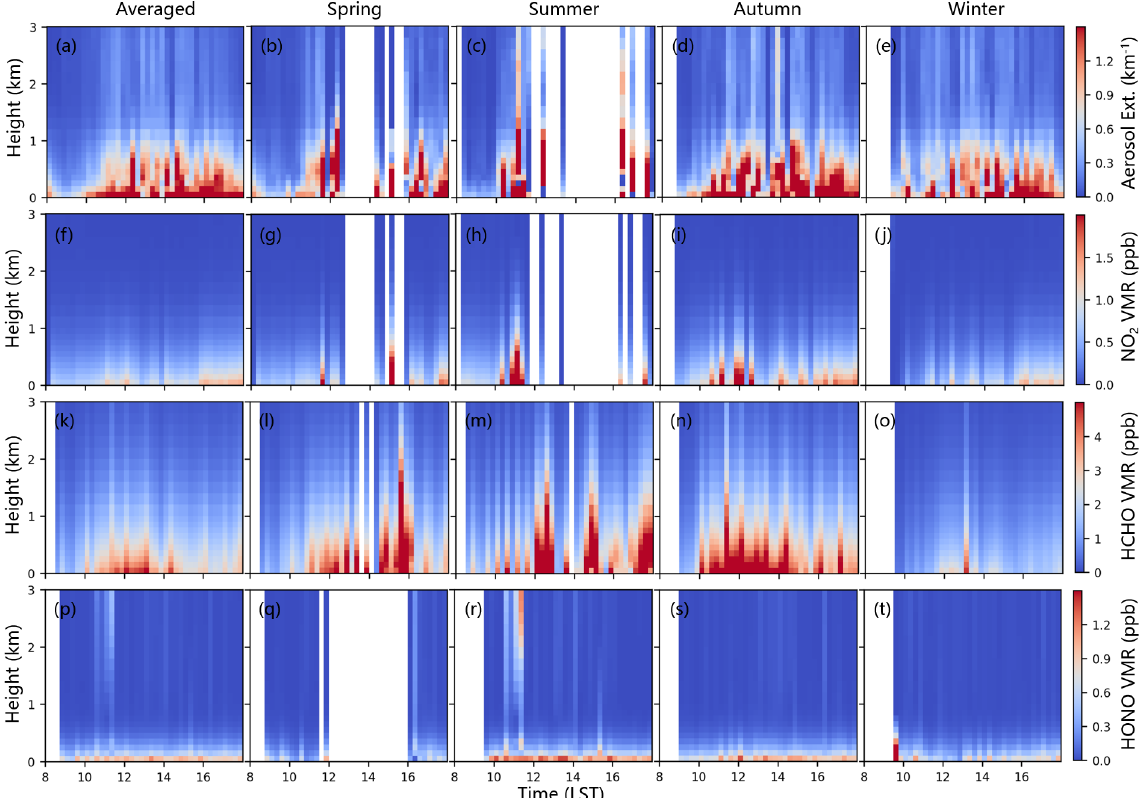
Figure 8. Diurnal variations in the total-averaged and seasonally averaged aerosol extinction profiles (a–e) , NO 2 profiles (f–j) , HCHO profiles (k–o) and HONO profiles (p–t) from December 2017 to February 2019 at CAS